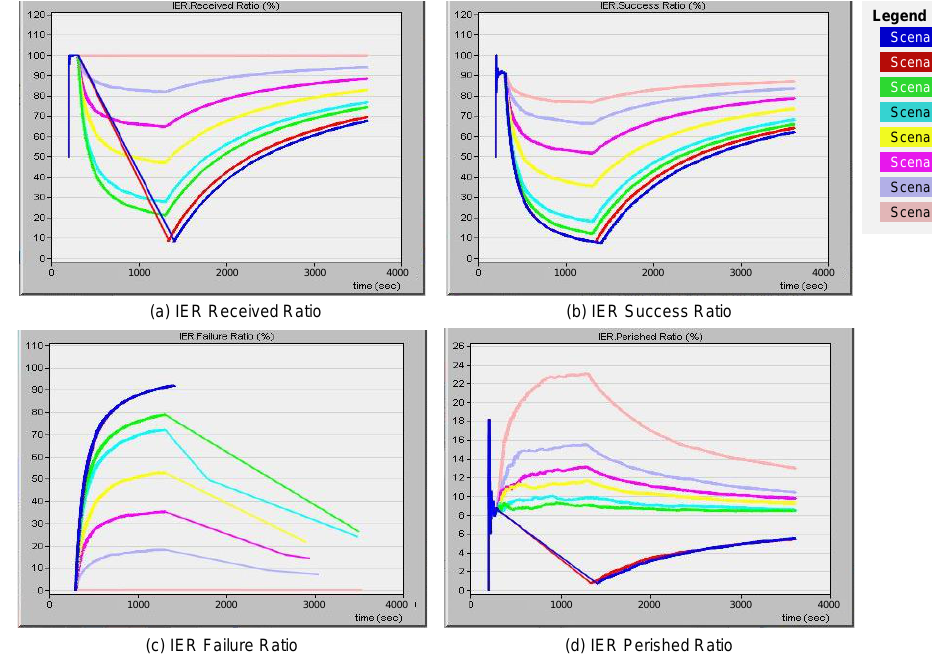
Figure 16. IER transmission characteristics under DDoS attack load.